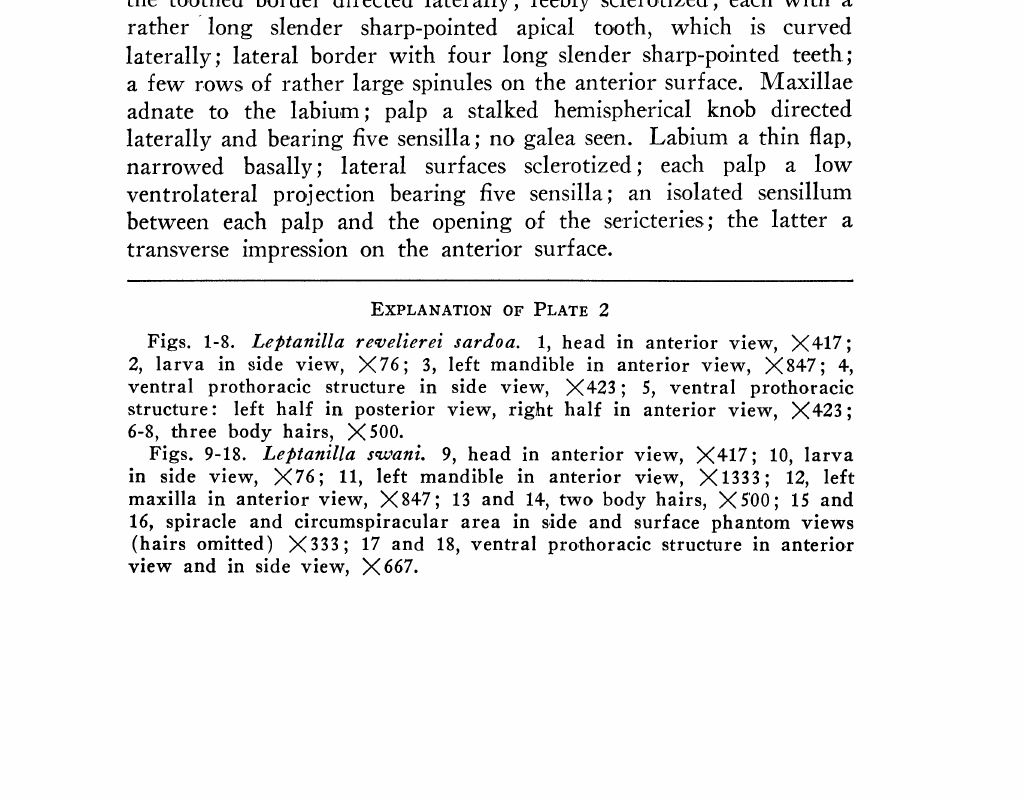
Figs. 1-8. Letanilla ree:elierei sardoa. 1, head in anterior view, X417; 2, larva in side view, X76; 3, left mandible in anterior view, X847; 4, ventral prothoraeie structure in side view, X423; 5, ventral prothoraeie structure: left half in posterior view, right half in anterior view, X423; 6-8, three body hairs, X500. Figs. 9-18. Leltanilla s,ani. 9, head in anterior view, X417; 10, larva in side view, X76; 11, left mandible in anterior view, X1333; 12, left maxilla in anterior view, X847; 13 and 14, two body hairs, X S’00; 15 and 16, spiracle and eireumspiraeular area in side and surface phantom views (hairs omitted) X333; 17 and 18, ventral pro.thoracic structure in anterior view and in side view,